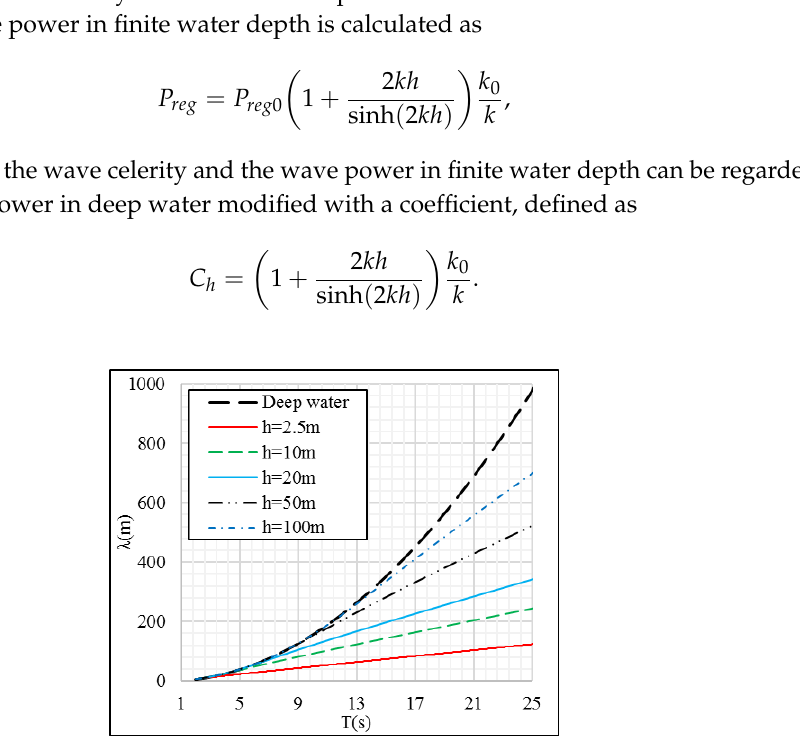
Figure 2. Wave lengths in finite water depths and deep water.